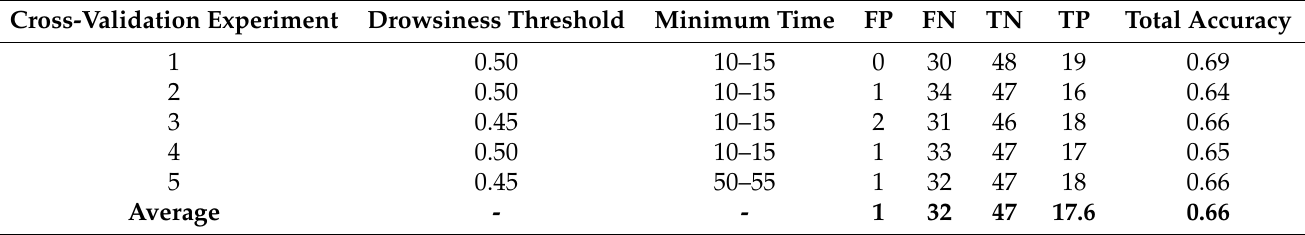
Table 9. Cross validation of the results obtained by Alternative II over train data.